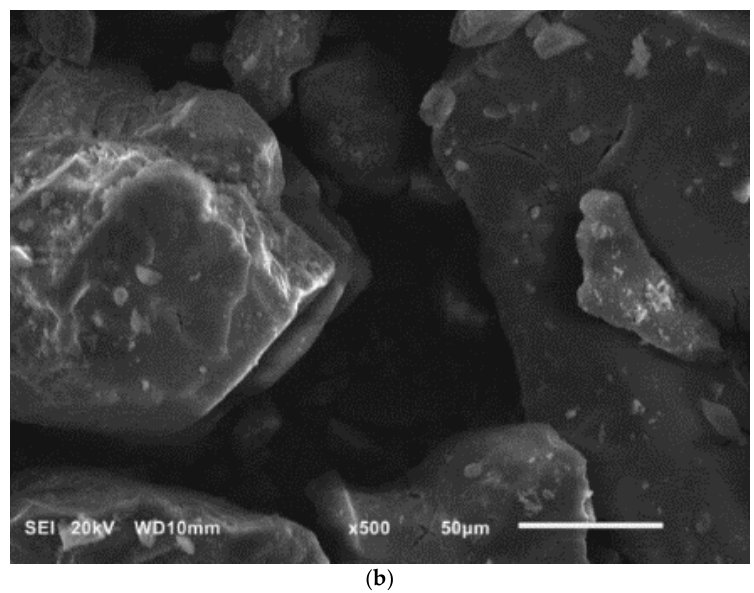
Figure 3. SEM images of diatomite ( a ) and aluminium potassium alum ( b ) (own study).